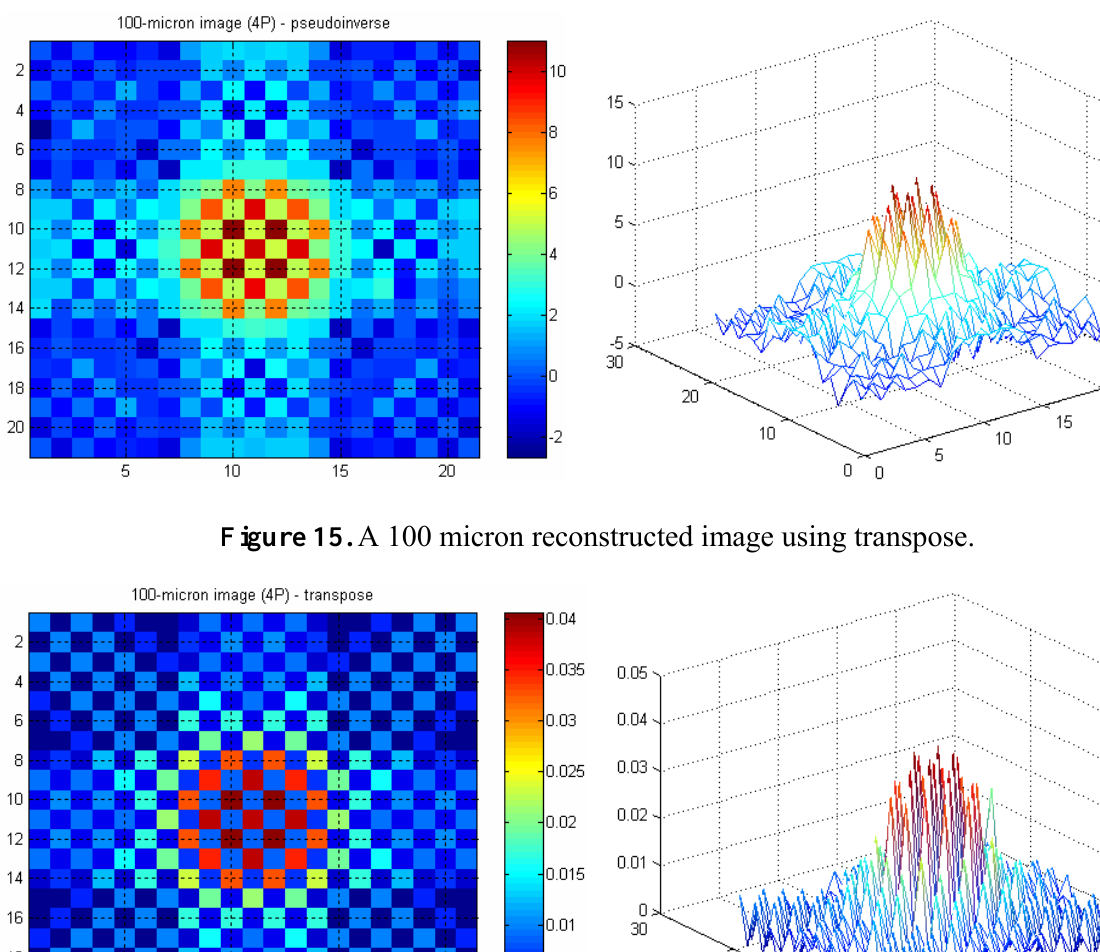
Figure 14. A 100 micron reconstructed image using pseudo inverse.